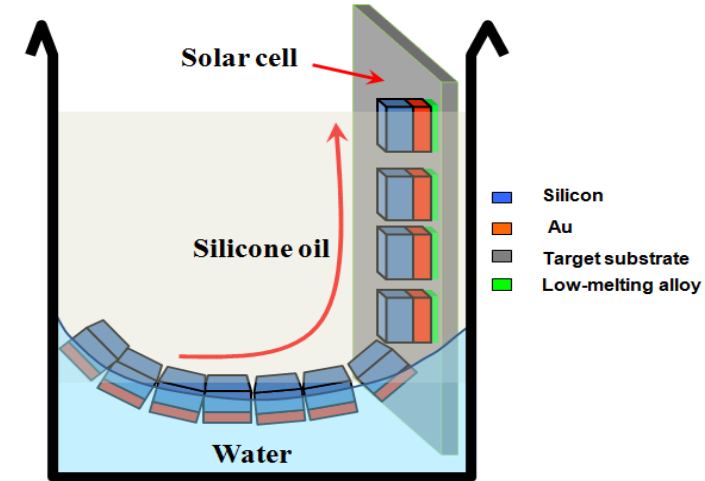
Figure 8. Procedure of surface tension-directed self-assembly at a liquid-solid interface (diagram illustrating the substrate being immersed and withdrawn from a silicone oil /water interface) (Reprinted with permission from [71]. Copyright 2010 Proceedings of the National Academy of